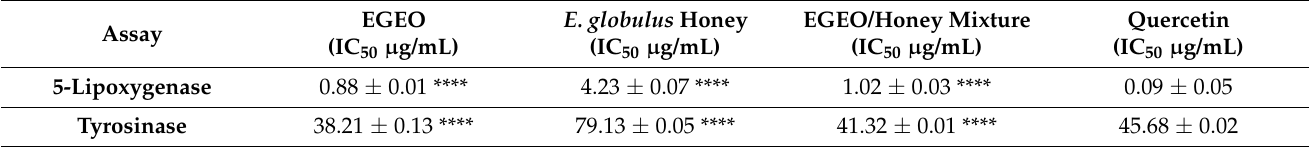
Table 4. In vitro anti-inflammatory and dermatoprotective